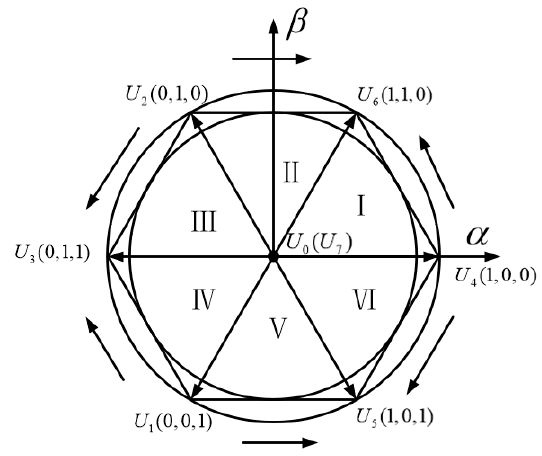
Figure 5. Voltage space vector diagram.